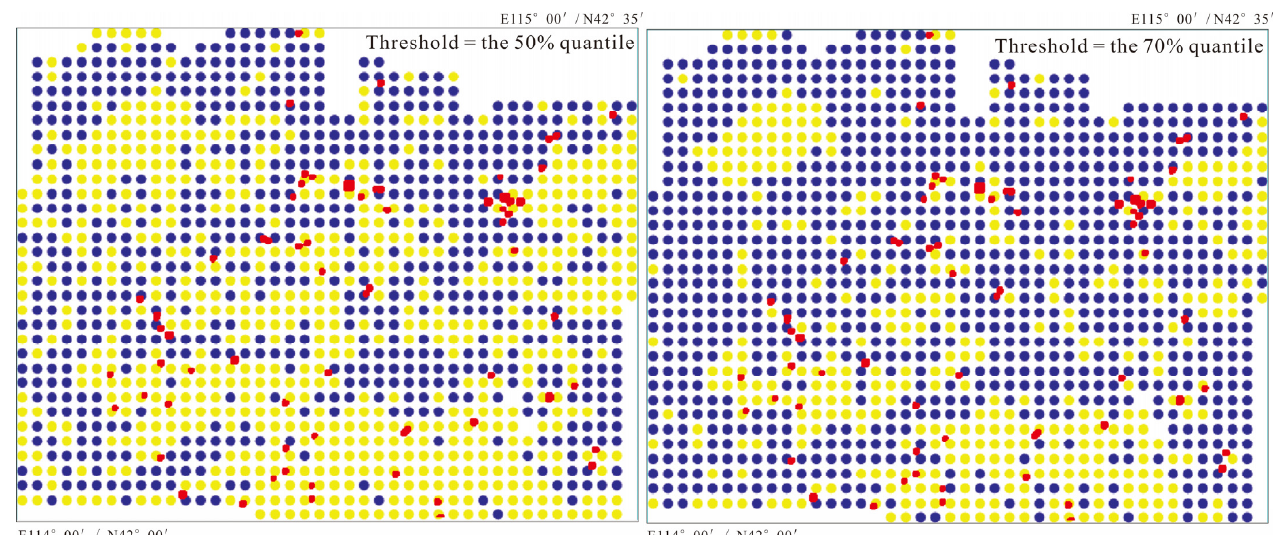
Figure 19. Anomaly map obtained by GAUGE. (left): threshold = the 50% quantile; (right) threshold = the 70% quantile. Note: the colored dots represent different geochemical sampling points; yellow dots denote anomalies and blue dots denote the background. All the known ore-spots (red squares), no matter what their scales and mineral species, are overlaid on the anomaly maps. The anomaly score maps are generated by using the geochemical dataset consisting of all 18 ore-forming elements as input to GAUGE.